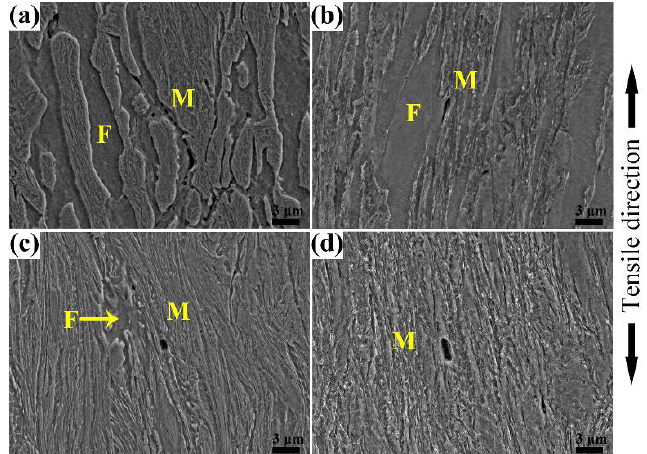
Figure 7. SEM microstructure of deformed HSLA steel next to the tensile fracture surface. ( a , b ) with 37 vol% ferrite tempered at 180 °C and 450 °C, respectively, and ( c , d ) with 3 vol% ferrite tempered at 180 °C and 450 °C, respectively.